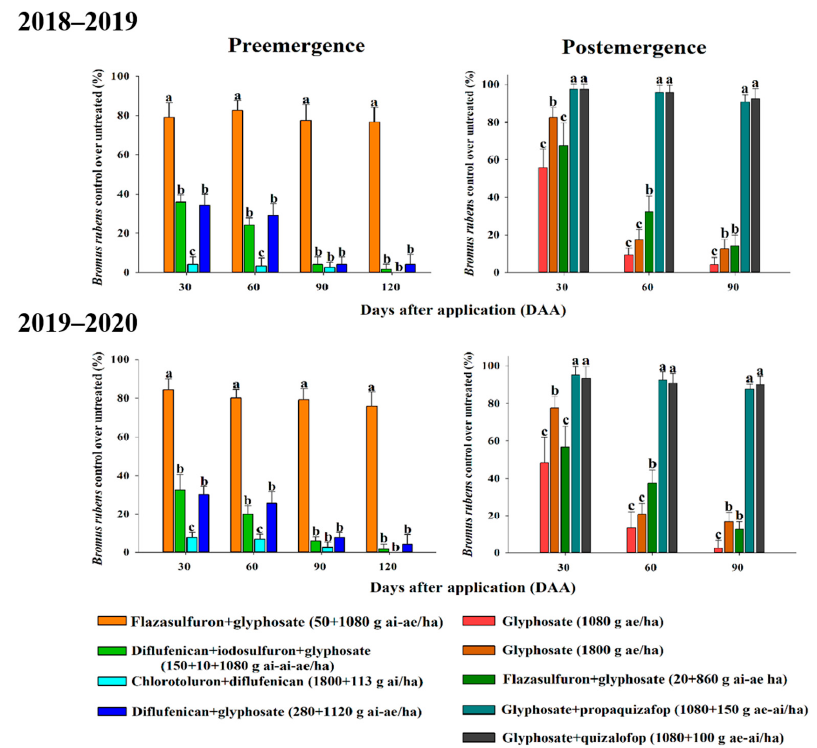
Figure 4. Percentage of control of Bromus rubens in pre-emergence and postemergence with different herbicides and days after treatment. The different letters in the measurements differed statistically in the LSD test (95%).